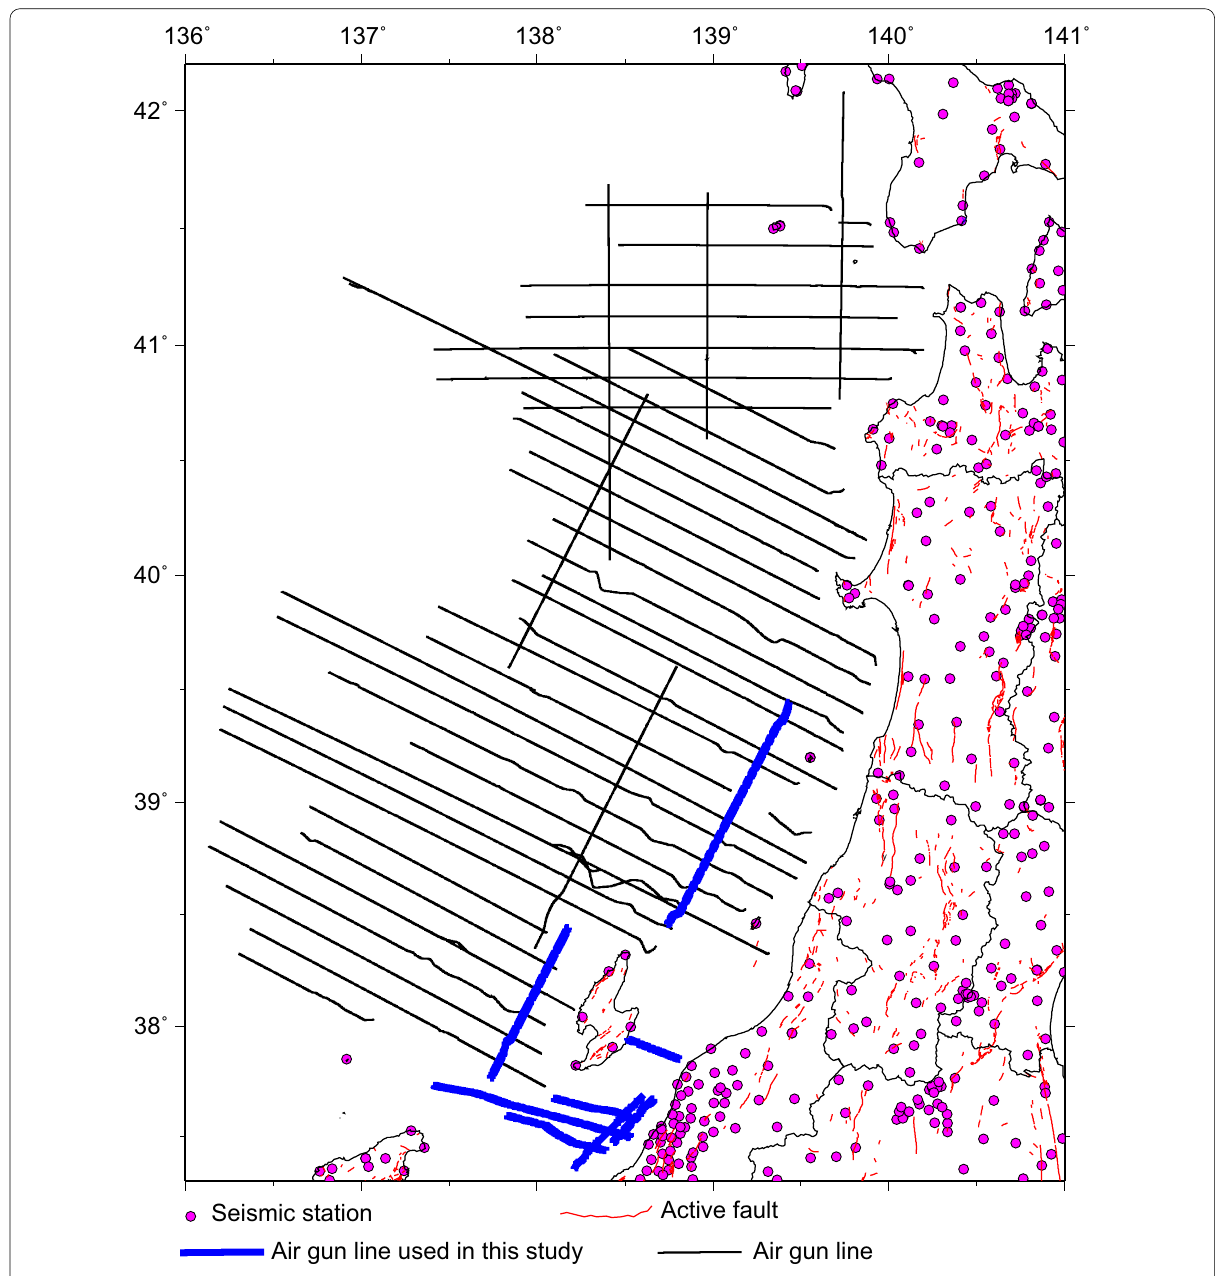
Fig. 2 Survey lines of reflection seismology by JAMSTEC (Shinohara et al. 2008; No et al. 2009,